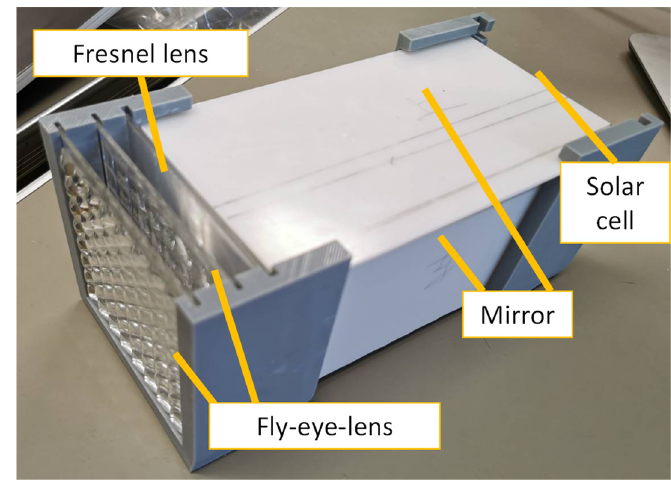
Figure 10. Fly ‐ eye lens module with 4 mirrors. Figure 10. Fly-eye lens module with 4 mirrors.